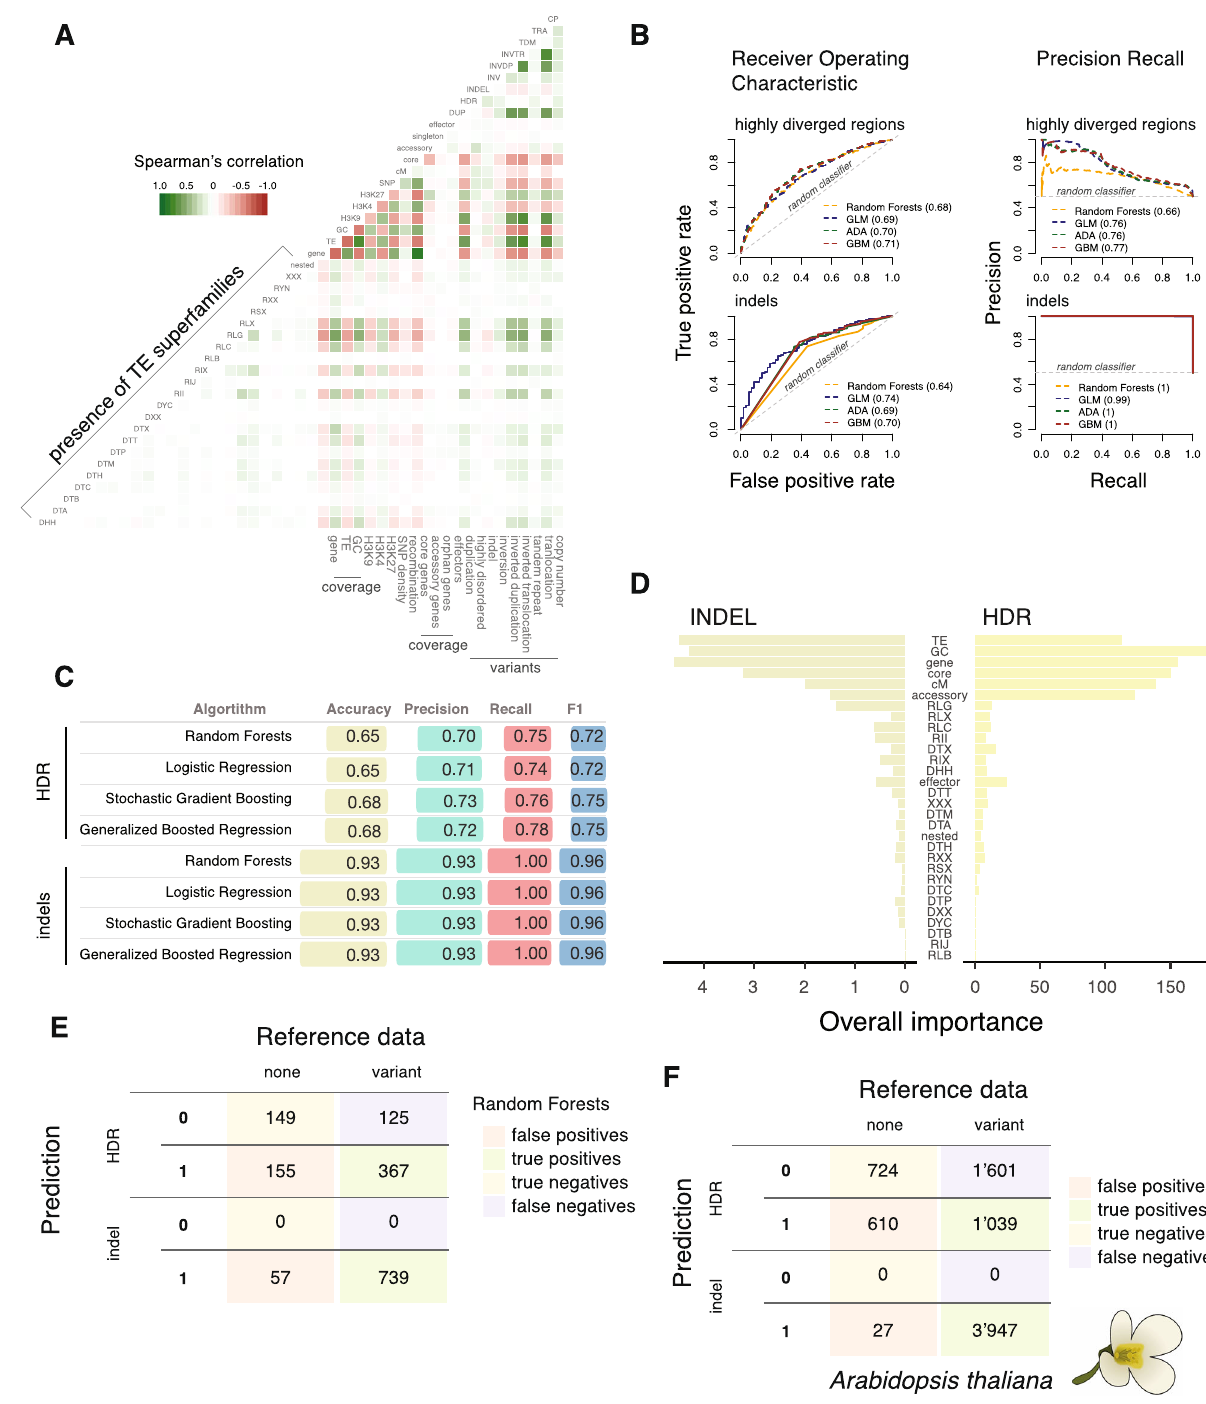
Fig. 4 A pangenome-informed model predicts the occurrence of structural variation. A Correlation analyses of 35 genome-wide metrics available for the reference genome IPO323 with types of structural rearrangements. Correlations were assessed from pairwise complete observations. B Receiving operating characteristics and precision-recall curves of the fi nal models trained using highly diverged regions (upper part) and indels (lower part). Four algorithms were analyzed including random forests, logistic regression (GLM), stochastic gradient boosting (ADA), and generalized boosted regression (GBM). Numbers in parentheses indicate the area under the curve for each of the four models. C Summary statistics of the fi nal models for translocations and indels using the four algorithms. Accuracy describes the model capacity at only detecting true variants. Precision measures the ability to predict true variants. Recall measures the ability to detect all true variants and the F1 score considers the harmonic mean of both precision and recall. D Relative importance of each of the 30 sequence features used in the training of the random forests model. The importance of individual sequence features is shown as the unscaled averages of the class-speci fi c scores. E Confusion matrix resulting from highly diverged regions and indel predictions using the two respective models trained with the random forests algorithm. F Confusion matrix of the highly diverged regions and indel predictions performed for the Arabidopsis thaliana pangenome.